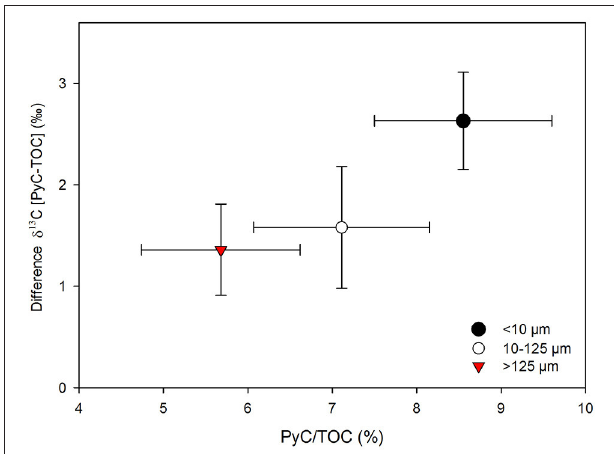
FIGURE 8 | Relationship between the relative contribution of PyC to TOC (%) and differences in δ 13 C between the PyC component and the TOC pool for different size fractions ( n = 23). Bars are standard errors of the